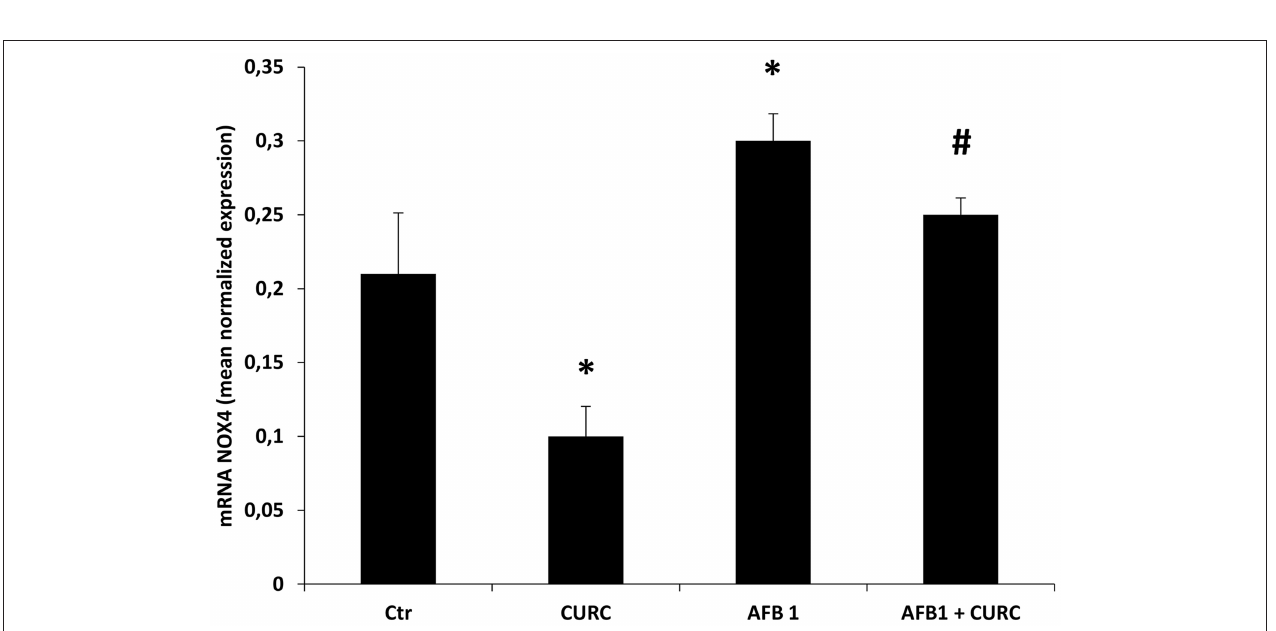
FIGURE 5 | mRNA NOX4 levels in the kidney of broilers at the end of treatment (T10). Values are presented as mean normalized expression toward GAPDH expression. Ctr, control group; CURC, Curcumin group; AFB1, Aflatoxin B1 group; AFB1 + CURC, Aflatoxin B1 group plus Curcumin. Data are expressed as mean ± standard deviation (SD), n = 8 (* p < 0.05 vs. Ctr; # p < 0.05 vs. AFB